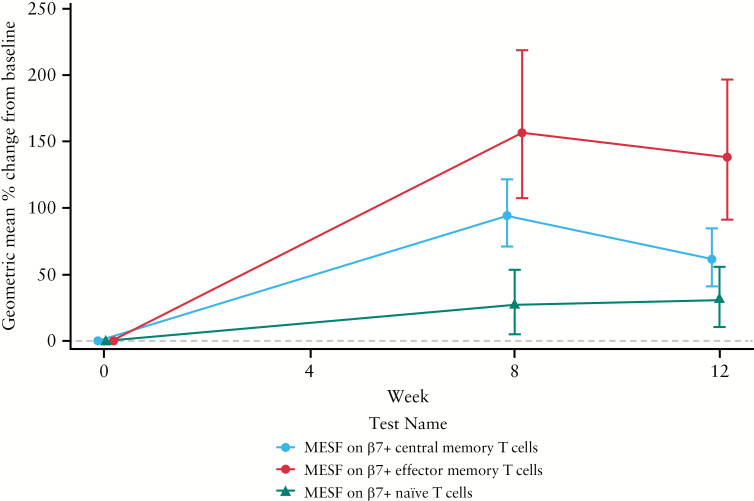
Effect of PF-00547659 on percent change from baseline of β7 expression in CD4+ cell subsets of patients with CD in the 225-mg group. Geometric mean % MESF change from baseline on β7+ in central memory, effector memory, and naïve T cells are calculated from data in Figure 2. CD, Crohn’s disease; FACS, fluorescence-activated cell sorting; MESF, molecules of equivalent soluble fluorochrome.